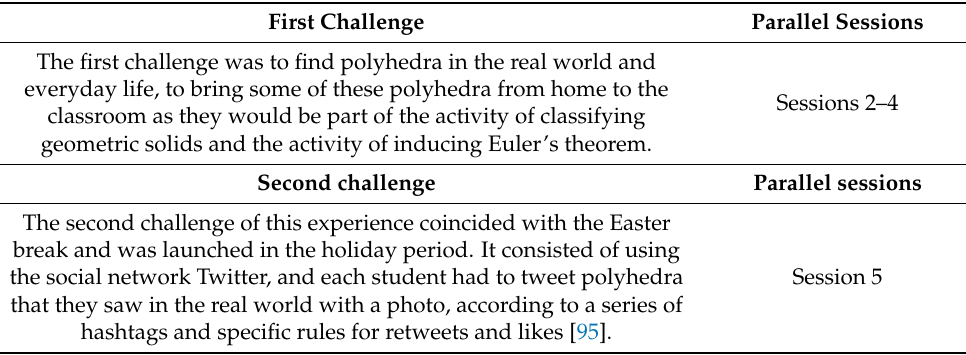
Table 2. Challenges and parallel